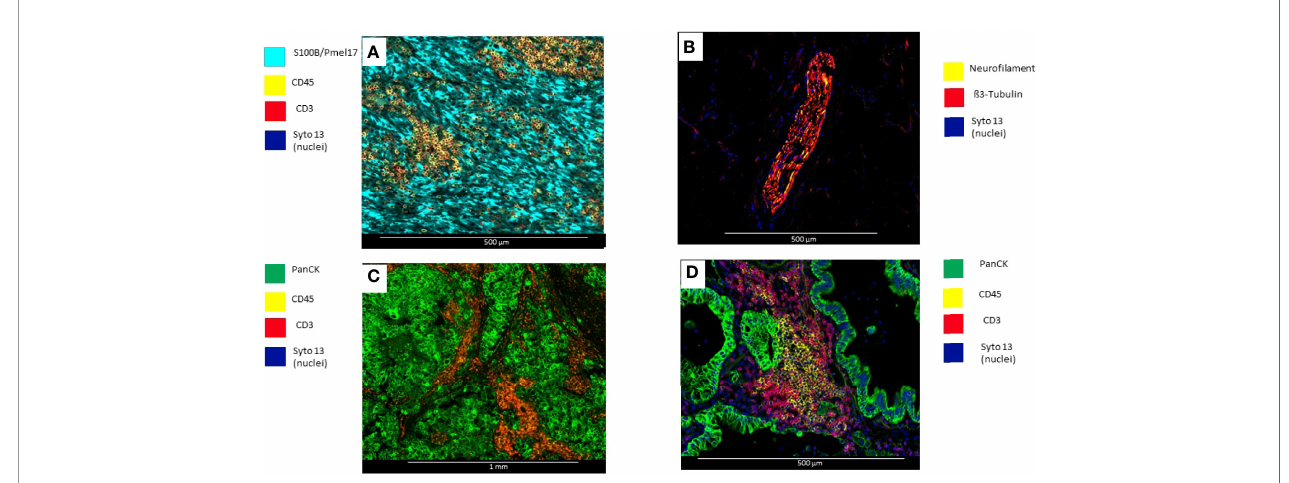
FIGURE 2 | Microphotographs showing immuno fl uorescence biomarkers used to visualize different elements of tumor tissues. (A) Surgical resected uveal melanoma sample stained with S100B/Pmell7 (melanoma cells), CD45 (immune cells), and CD3 (T-cells). (B) Surgical resected colon sample with a peripheral nerve identi fi ed by b 3-Tubulin and Neuro fi lament. (C) Surgical resected breast carcinoma stained with PanCK (tumor), CD45 (Immune cells), and CD3 (T-cells) (D) Surgical resected lung carcinoma stained with PanCK (adenocarcinoma cells), CD20 (B-cells) and CD3